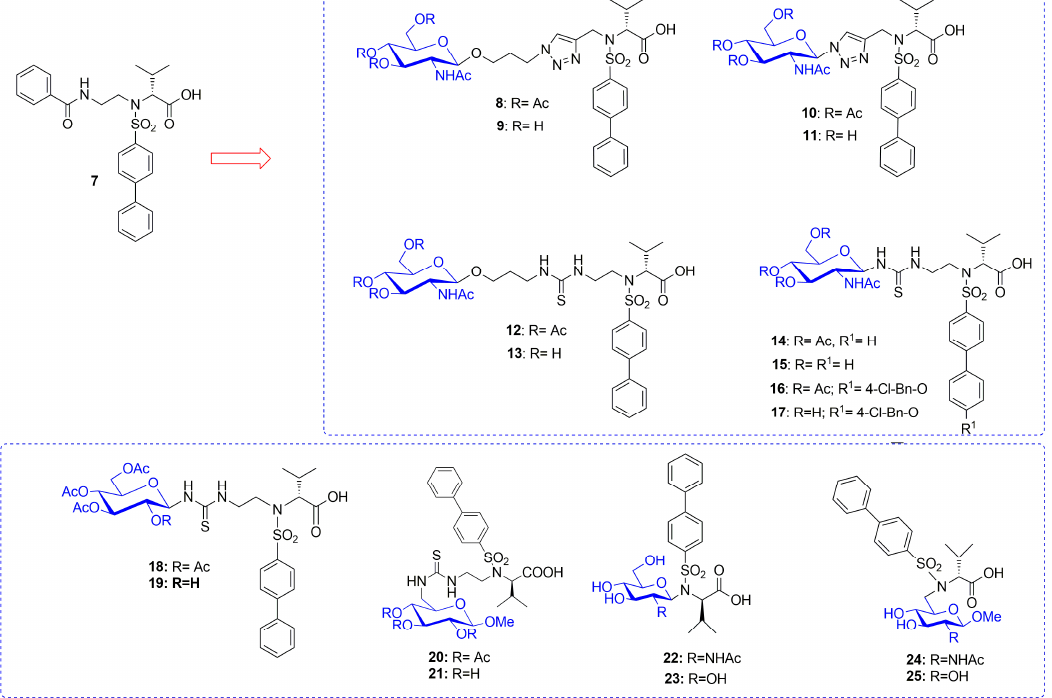
Figure 7. Chemical structure of sugar-based arylsulfonamido MMPIs 8–25 and the parent compound 7